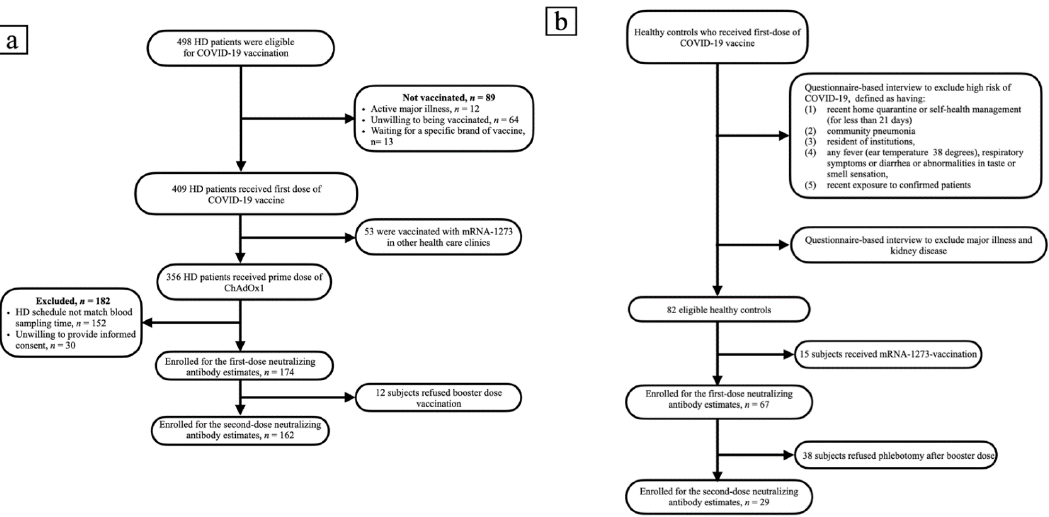
Figure 1. ( a ) Flow chart of patients on hemodialysis selected for neutralizing antibody measurement. ( b ) Flow chart of recruitment of healthy controls.